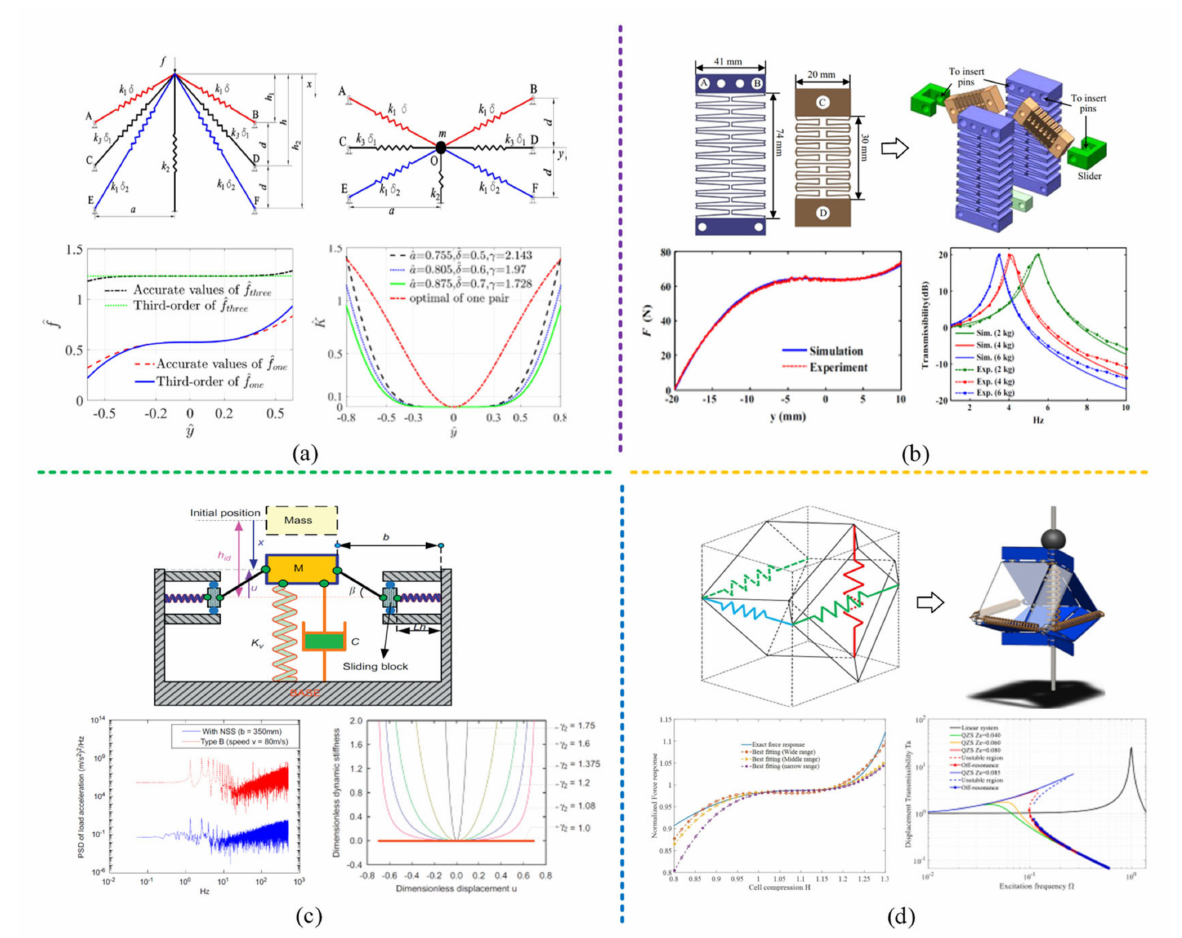
Figure 8. Structure and vibration isolation performance of four typical mechanical spring QZS vibration isolators: ( a ) Multi-spring structure proposed by Zhao et al. [8–10]; figures adapted with permission from Ref. [9]. Copyright 2021, copyright Zhao, F.; ( b ) Special spring structure (planar spring) proposed by Lan et al. [21]; figures adapted with permission from Ref. [21]. Copyright 2014, copyright Lan, C.C.; ( c ) Slider block-guide rod structure proposed by Danh Le et al. [23,24]; figures adapted with permission from Ref. [23]. Copyright 2011, copyright Le, T.D.; ( d ) Origami structure proposed by Ye et al. [26]; figures adapted with permission from Ref. [26]. Copyright 2022, copyright Ye,